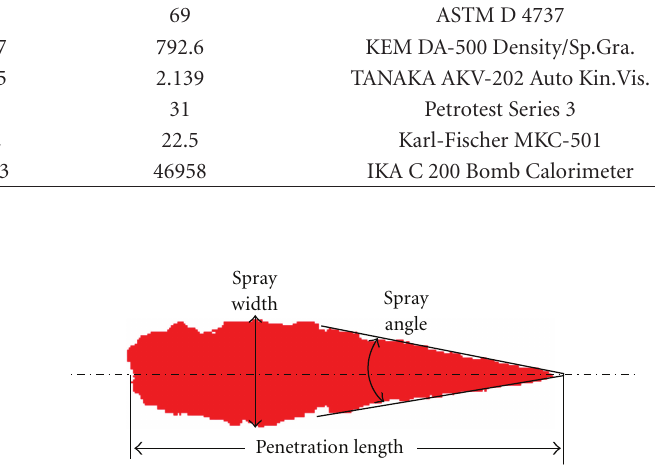
Figure 6: Measurement points of spray. Red color represents the spray projection